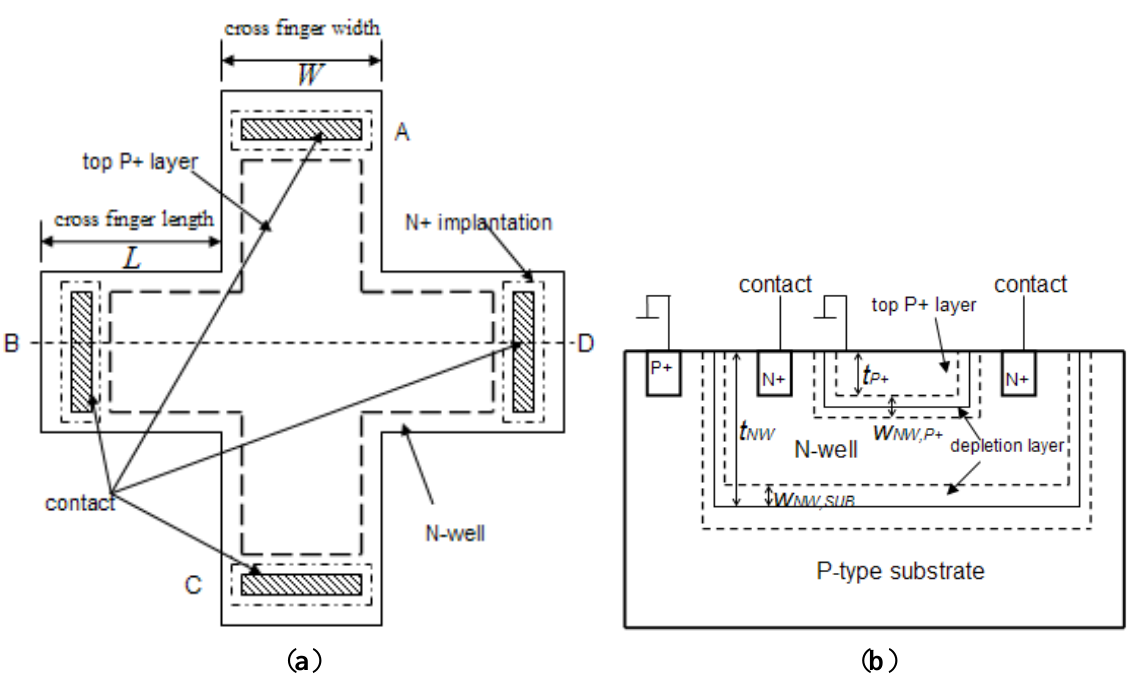
Figure 3. Cross-shaped Hall plate fabricated in standard CMOS technology. ( a ) Top view; ( b ) View with the cross-section along B and D